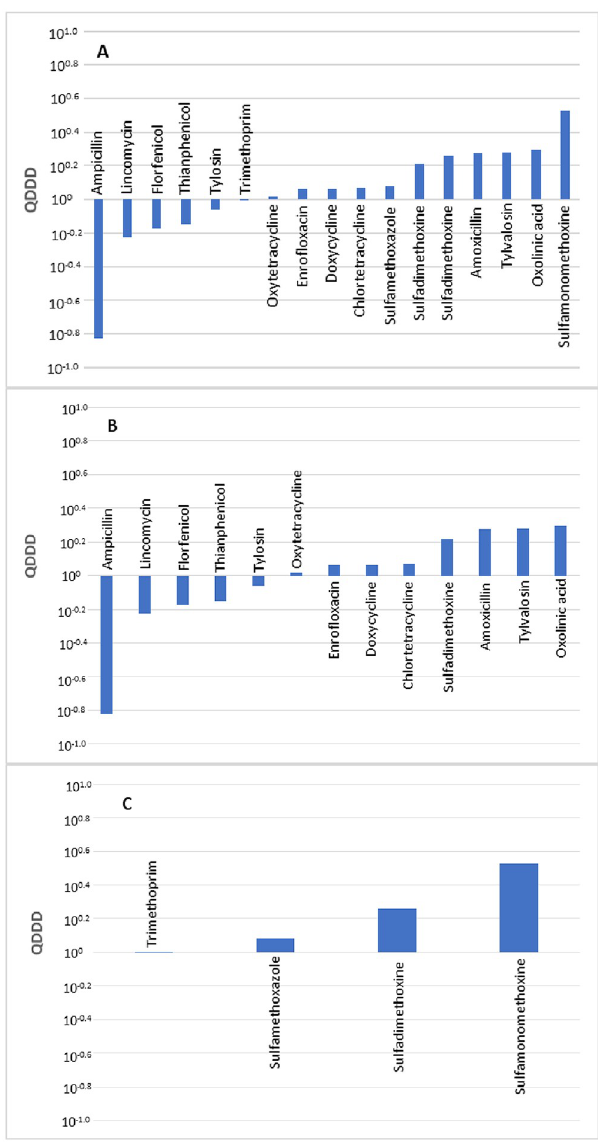
Fig 3. Comparison of the defined daily doses in Japan (DDDjp) of antimicrobial agents approved for use in poultry with the corresponding values of the European Medicines Agency (DDDvet). Bars indicate an antimicrobial agent for which both DDDjp and European values of DDD (DDDvet) values are available with QDDD (DDDjp/DDDvet) values in ascending order. Comparison of all antimicrobials (A), antimicrobial agent used in single substance products (B) and antimicrobial agents used in combination products (C). Comparison was not made by administration route because there was no antimicrobial agent for injection for which DDDvet and DDDjp values were